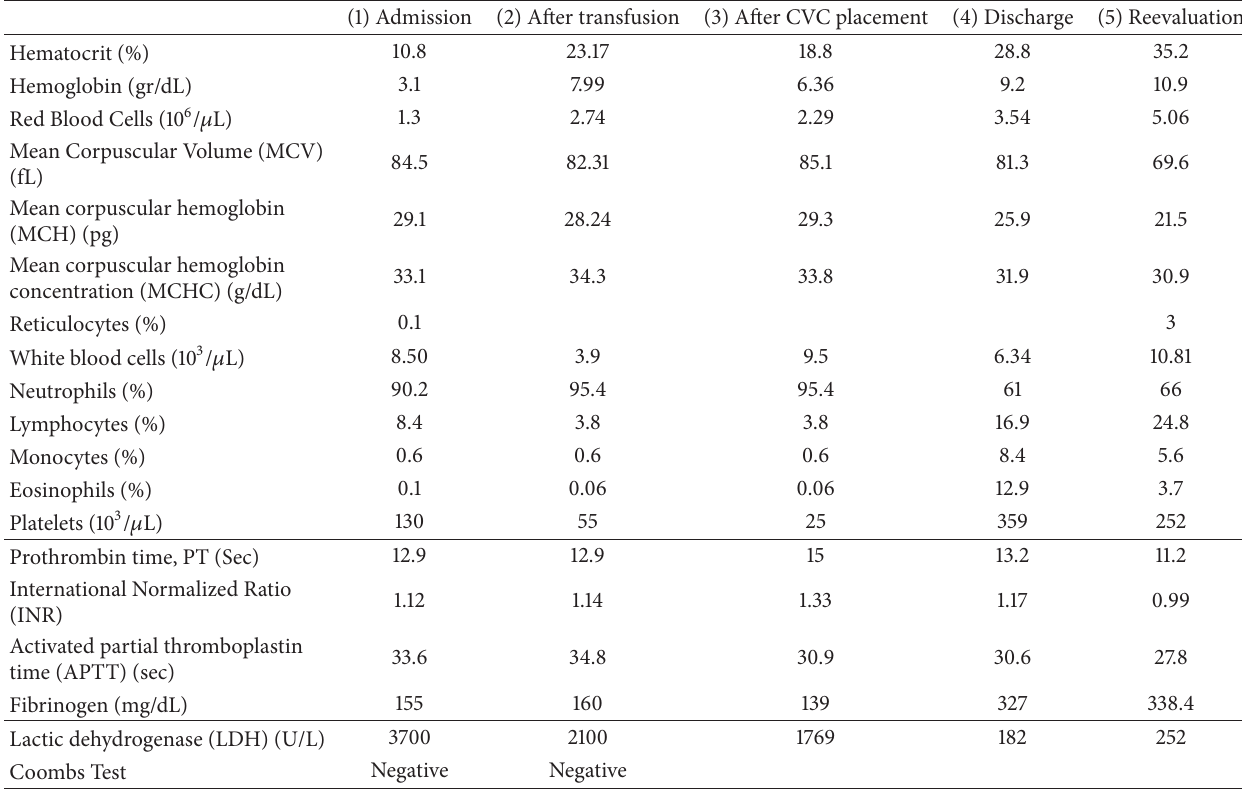
Table 1: Patient’s blood results: (1)during admission, (2)after thetransfusionof 4 packed RBCsunits,(3) after theCVC insertion,hemothorax and intubation, (4) at discharge after having received therapy for B12 deficiency, (5) and finally during reevaluation as an